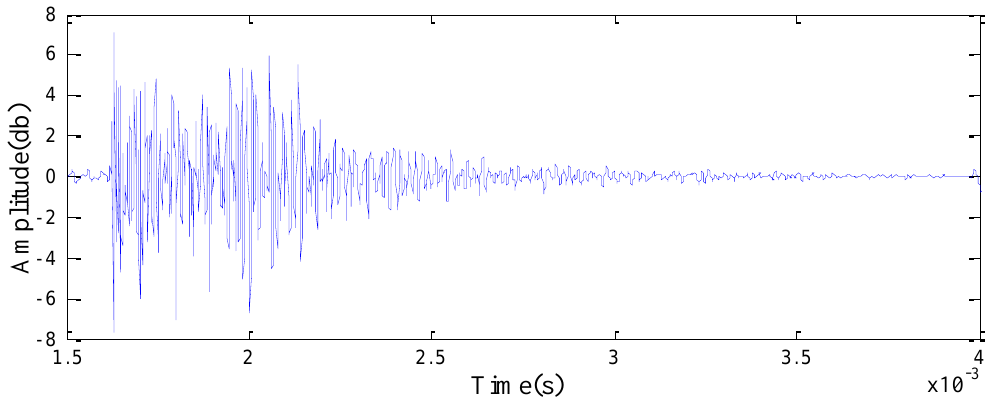
Figure 5. AE signals of lead-breaking in time domain.